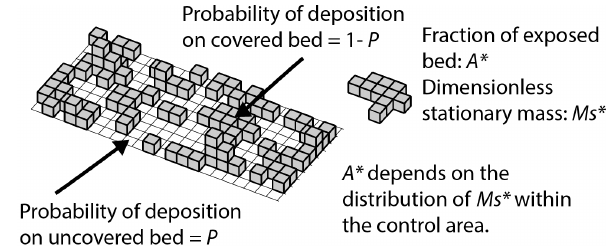
Figure 1. Cartoon illustration of a bed partially covered by sedi- ment. For purpose of illustration, the bed is divided into a square raster, with each pixel of the size of a single grain. For a given number of particles in the area of the bed of interest, the exposed area fraction of the bed is dependent on the distribution of particles. Grains that sit on top of other grains do not contribute to cover. The probability that a new grain is deposited on uncovered bed is given by P (Eq.